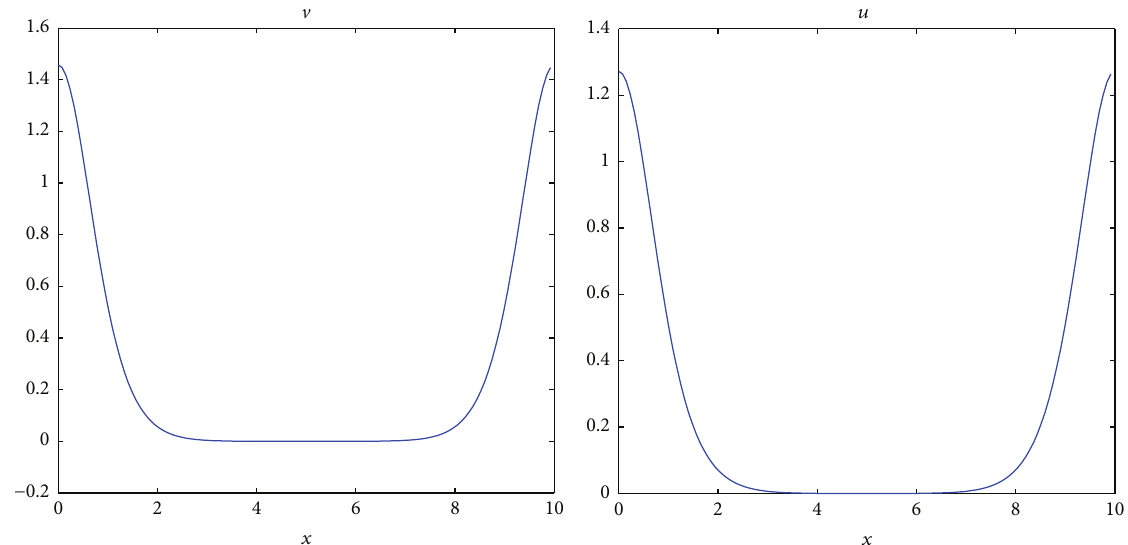
Figure 4: Periodic travelling wave solution of system (75) for 𝛼 = 𝛽 = 0.3 , 𝜎 = 0.3 , wave speed 𝑐 = 1.2 , and period 𝐿 = 10 , obtained after 7 Newton’s iterations.